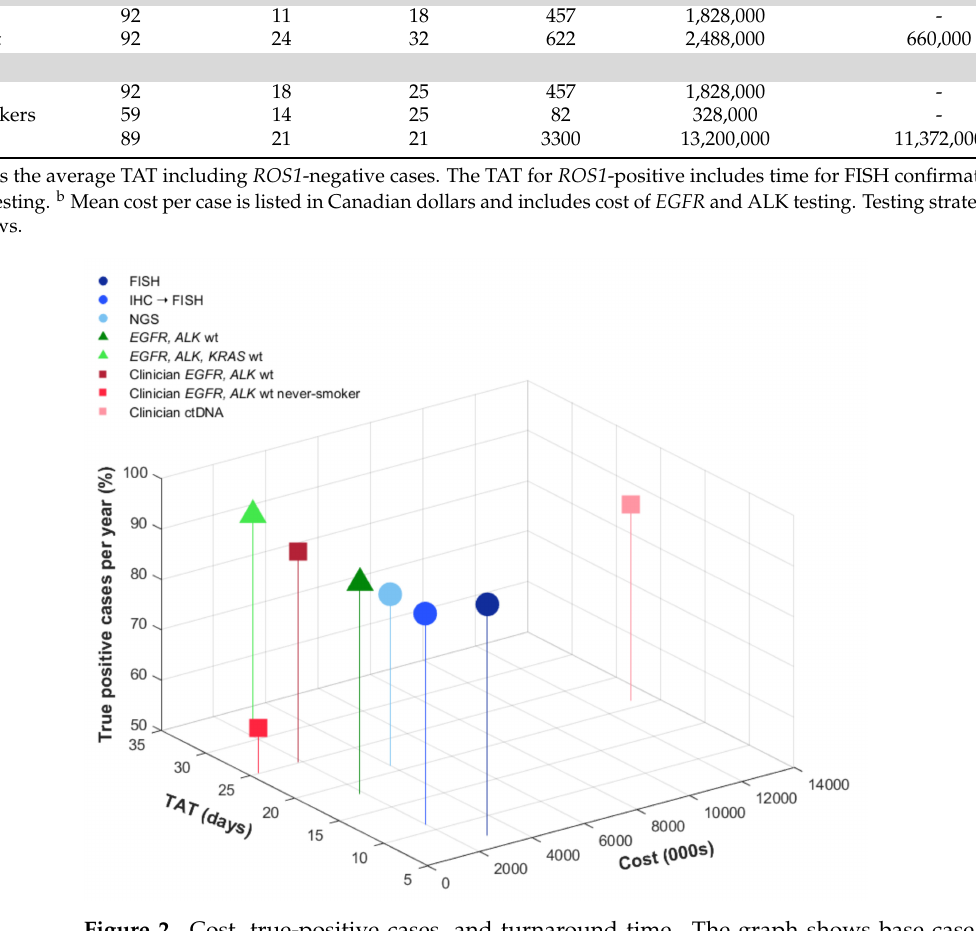
Figure 2. Cost, true-positive cases, and turnaround time. The graph shows base case analysis results of true-positive cases detected, turnaround time (in days), and cost (CAD). Reflex strategies initiated at diagnosis are shown in blue, biomarker-informed pathologist-initiated testing in green, and clinician-initiated strategies in